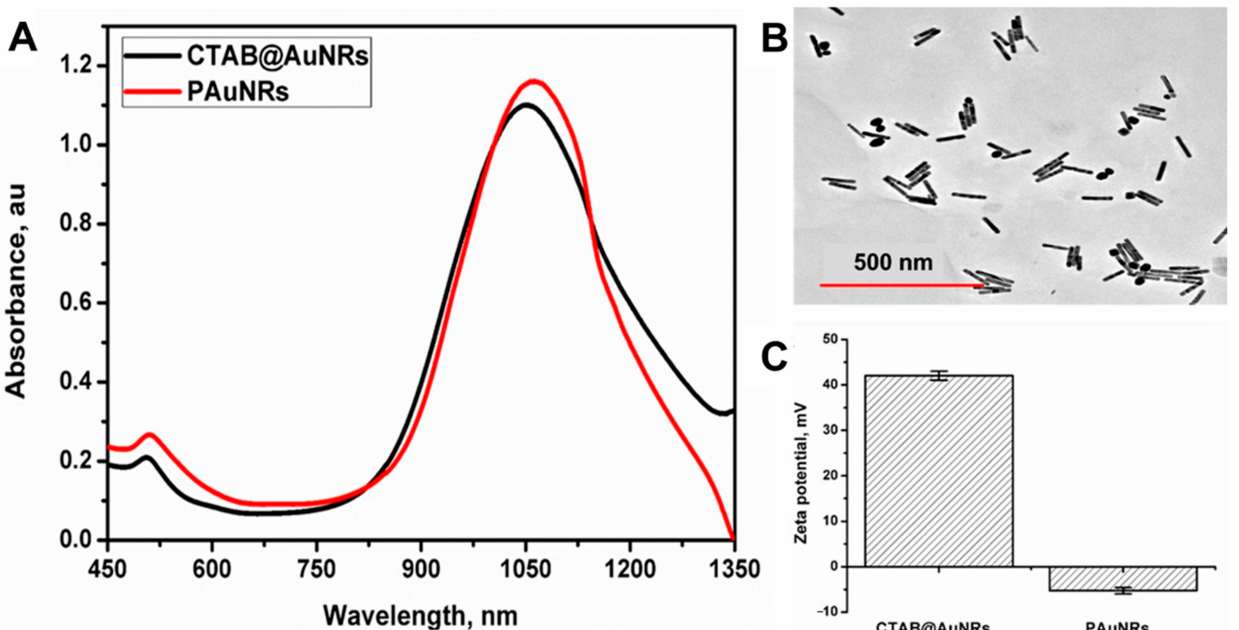
Figure 1. ( A ) Absorption spectra of AuNRs and PAuNRs. ( B ) TEM image of AuNRs (scale bar = 500 nm). ( C ) Surface charge (zeta-potential) of AuNRs and PAuNRs (mean ± SD, n =